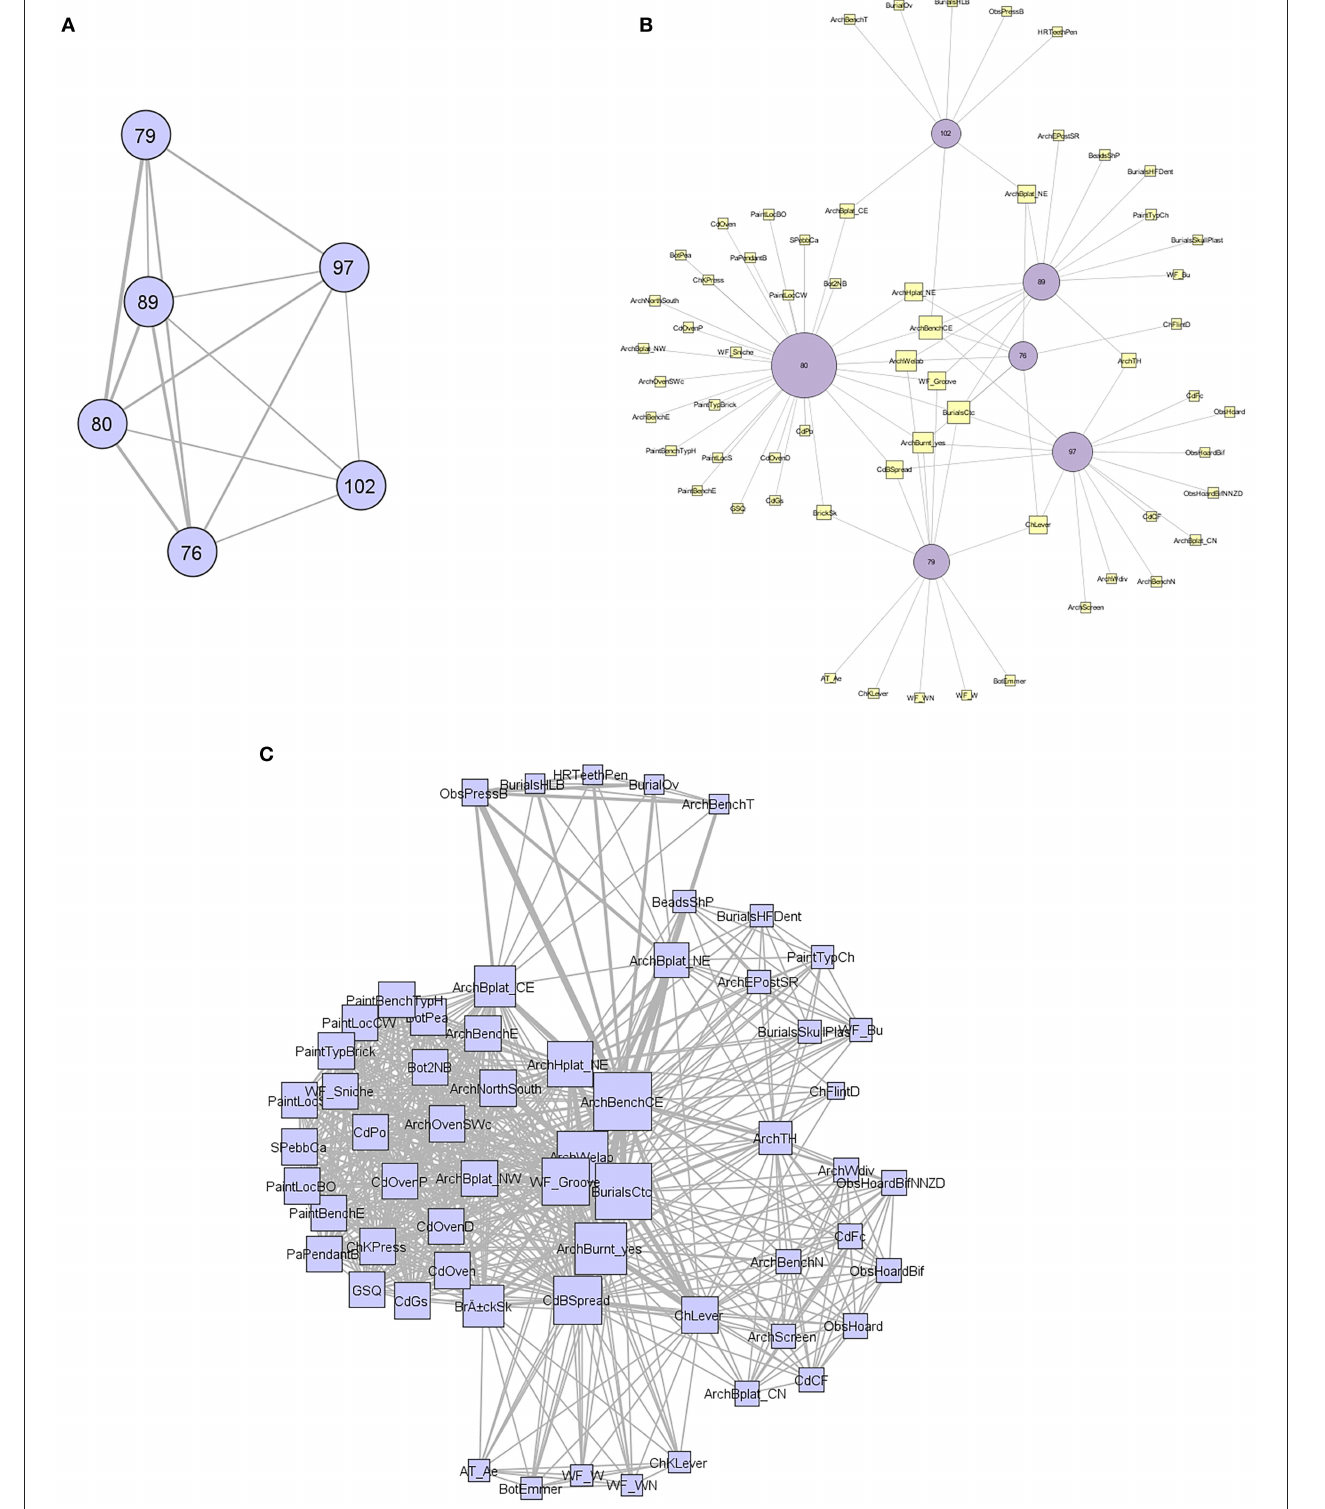
FIGURE 10 | Middle network purple module (A) . 2-mode network ( B size of nodes according to degree centrality) and object network (C) (The codes used are in the Supplementary Material ).